Question: Condense the content of this figure into a single sentence.
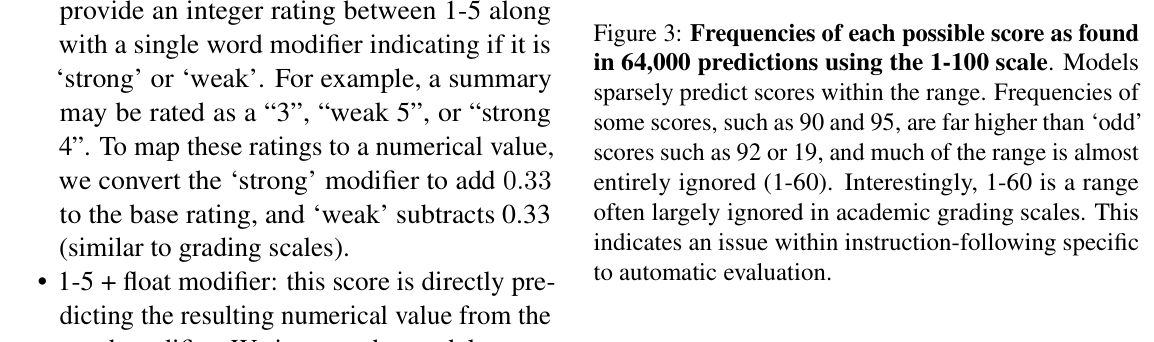
Answer: shows the distribution of scores pro- duced when instructing GPT-3.5-Turbo and GPT-4 to rate summaries on a 1-100 scale. The scores in this distribution are not respected as intended, and the model assigns outsized probabilities to certain scores such as 90 and 95. This reaffirms results by Zheng et al. (2023a) which found that multiple- choice selections by LLMs suffered from similar token biases, deteriorating performance. The full range is also not utilized, with predicted scores largely occurring between 70 and 100. Figure 3 also shows that the score distribution has several peaks for round numbers such as 60, 70, 80, 90 (Similarly for 75, 85, and 95), indicating that LLM evaluators also have round number bias like human.2